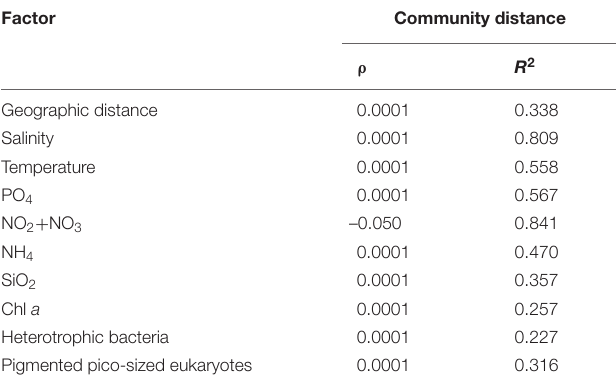
TABLE 2 | Mantel test comparison between community variability (measured as Bray–Curtis dissimilarity) and environmental biotic and abiotic factors. When the correlation is significant both ρ -value and R 2 are bold ( p <